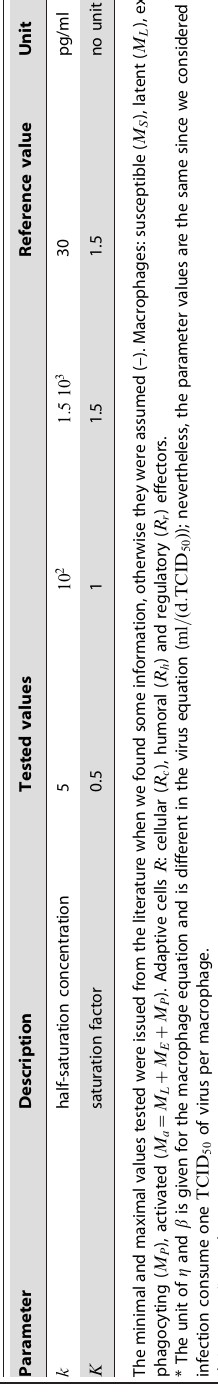
1 T helper cell from the R c compartment (basic rate d R N Cellular response: R c represents the type 1 T helper cells and the cytotoxic lymphocytes. Its dynamics is described in Equation (3). Activation is amplified by IFN c and IL 12 and inhibited by IL 10 ; proliferation is activated by IFN c and IL 12 and inhibited by IL 10 and TGF b (4a in Figure 1). R c macrophages (7 in Figure